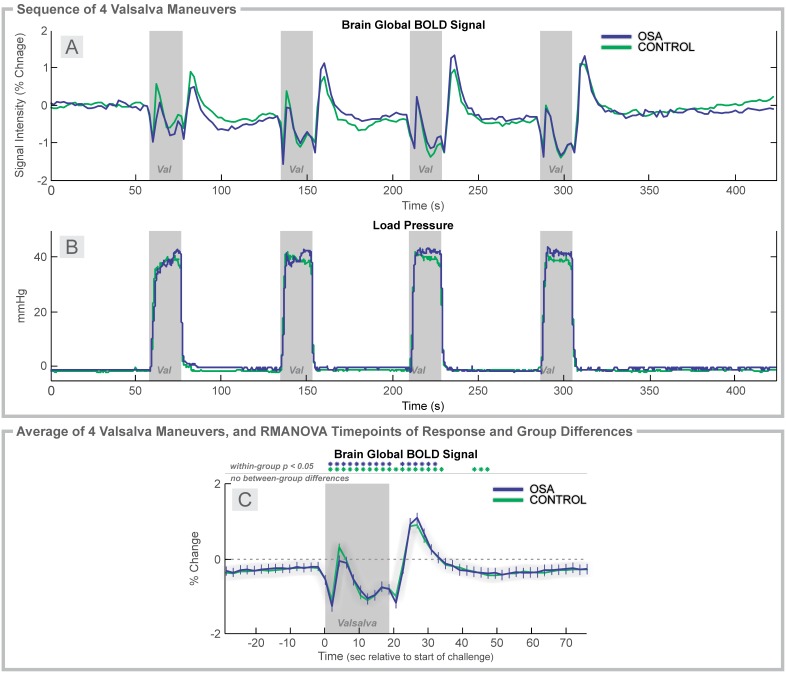
Valsalva, 2 group.Time course of global BOLD signals over four Valsalva maneuvers (Val; gray rectangles). A: Global BOLD signal, and B: expiratory pressure in 37 OSA and 57 control subjects during the complete sequence. C: Average over four challenges of change in BOLD signals relative to baseline (group mean ± SE), with time-points of significant increase or decrease relative to baseline within-group, and time-points of between-group differences (RMANOVA, p<0.05).